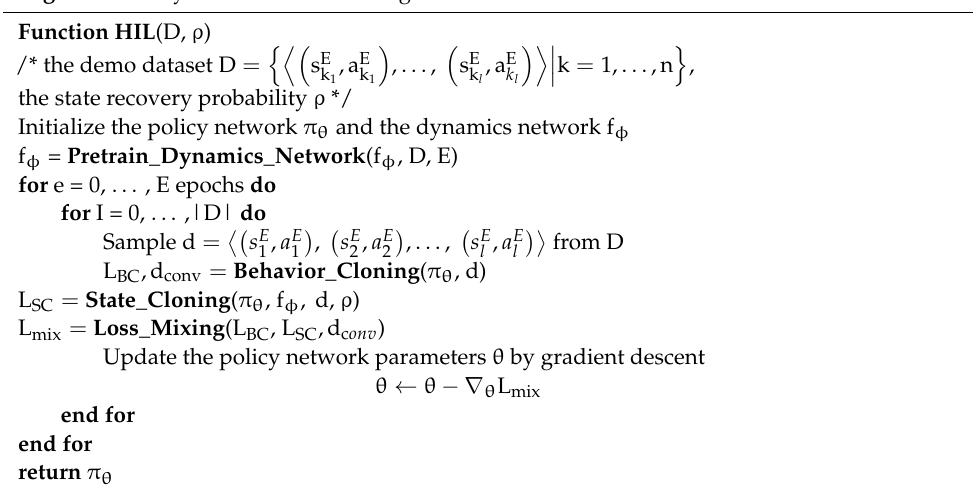
Algorithm 1. Hybrid imitation learning